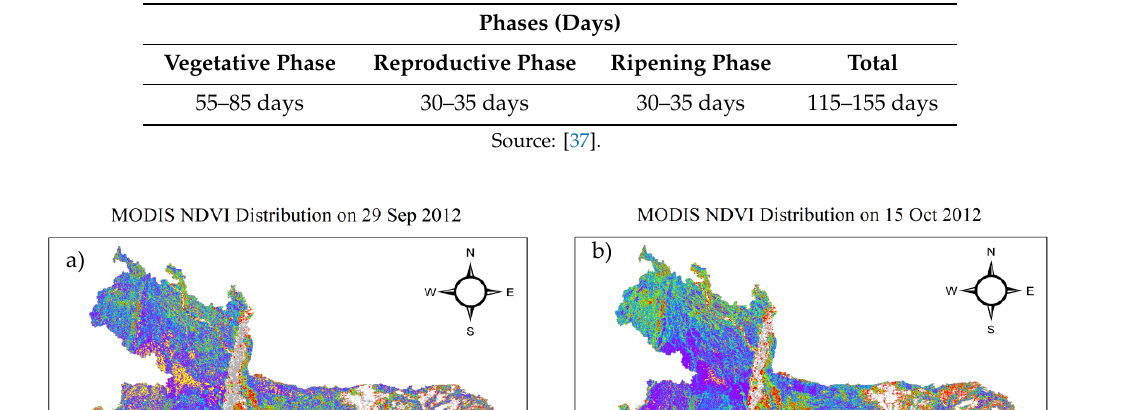
Table 1. Phenological stages of Aman crop.